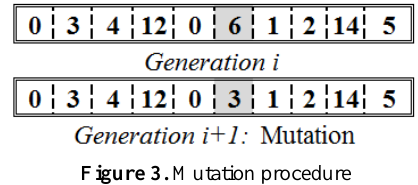
Figure 3. Mutation procedure